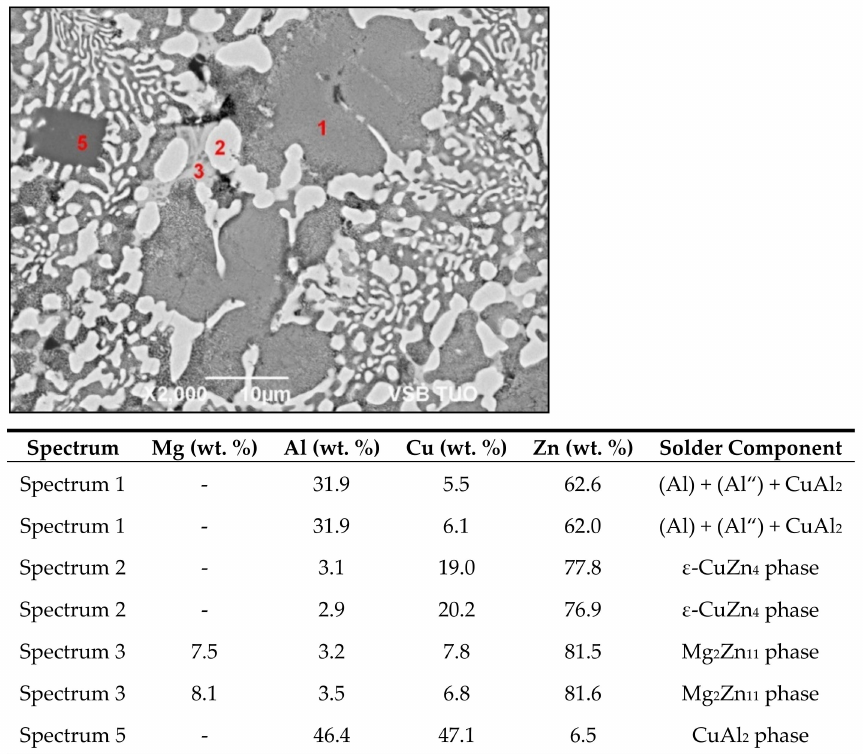
Figure 13. EDX analysis of solder structure in soldered joint of